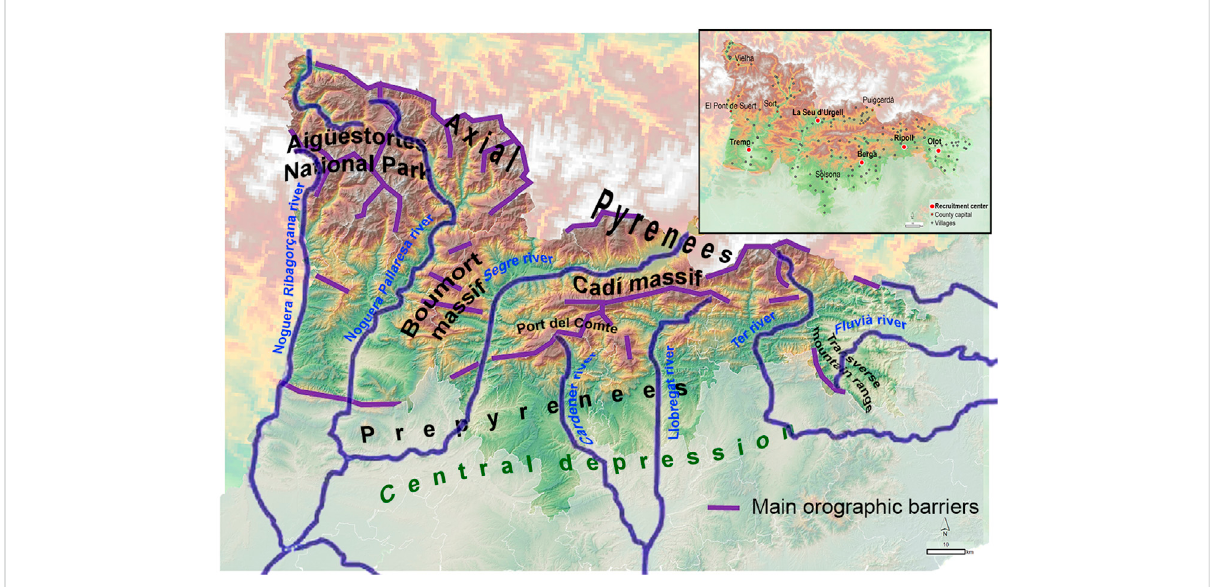
FIGURE 1 OrographicmapofthecatalanPyreneanregionconsideredinthisstudy,depictingthemostrelevantorographic elementsasmassifs,riversand depressions. Labeled by purple line the main orographic barriers de fi ned by mountains higher than 1,500 m. Insert: location of villages (gray dotted points), comarca capitals (red dotted points), and recruitment centers (white-red